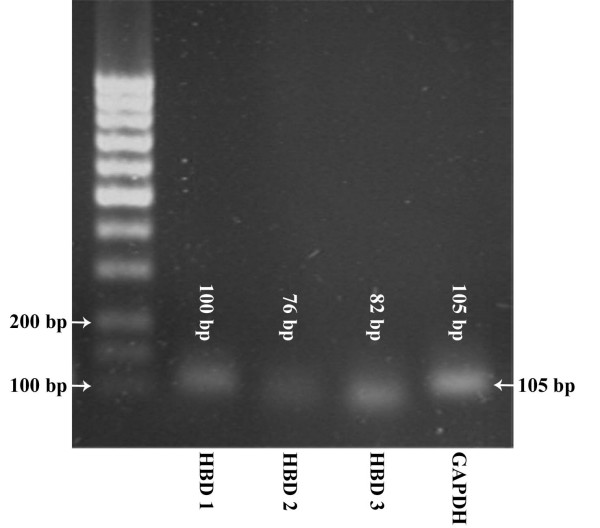
PCR products of hBDs and housekeeping gene (GAPDH) on 2% agarose gels.